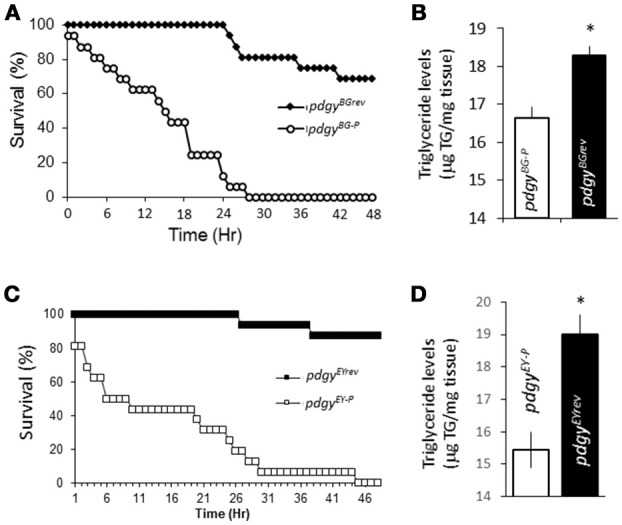
pdgy mutants display metabolic phenotypes. (A) Under starvation conditions, the pdgyBG−P displayed decreased survival compared to background controls, pdgyBGrev. (B)
pdgyBG−P had decreased lipid stores compared to background controls. (C,D) Starvation phenotypes compared to its background control (pdgyEYrev) as the pdgyBG−P
(D) and pdgyEY−P shows a similar triglyceride phenotypes. *p < 0.05.